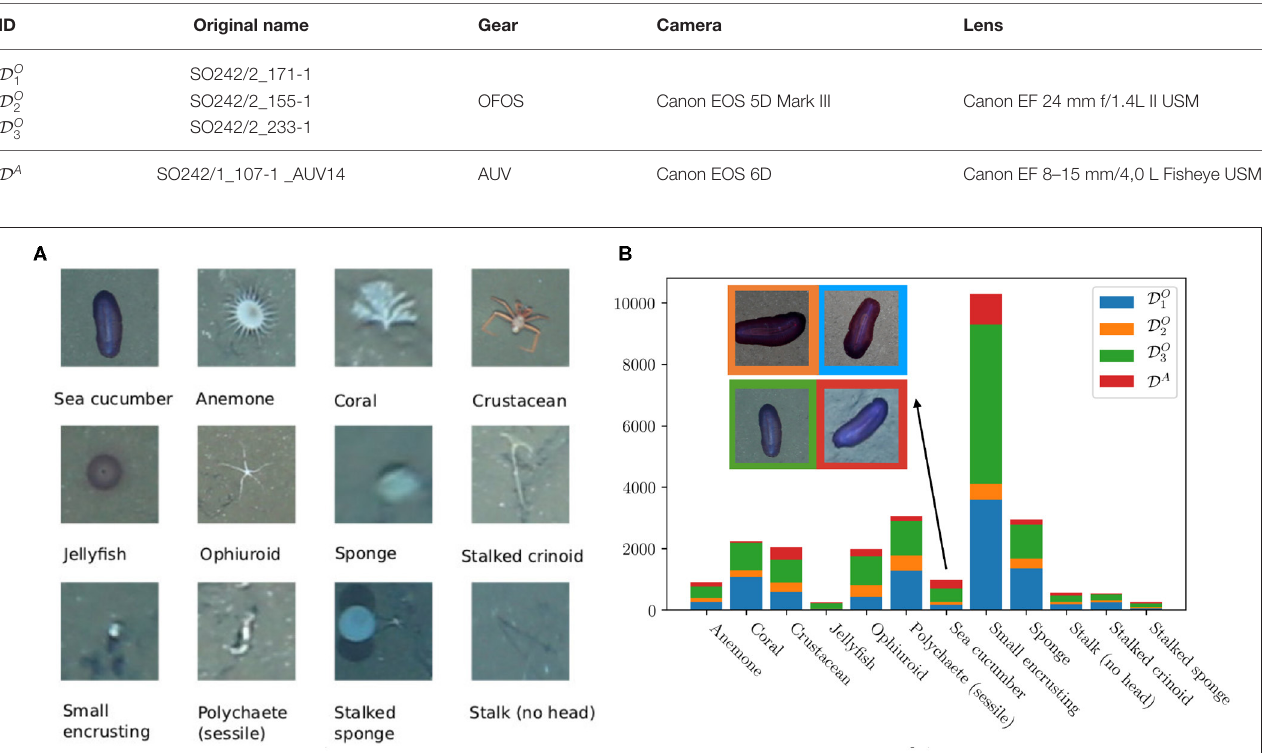
TABLE 2 | The four data sets included between 154 and 311 images.